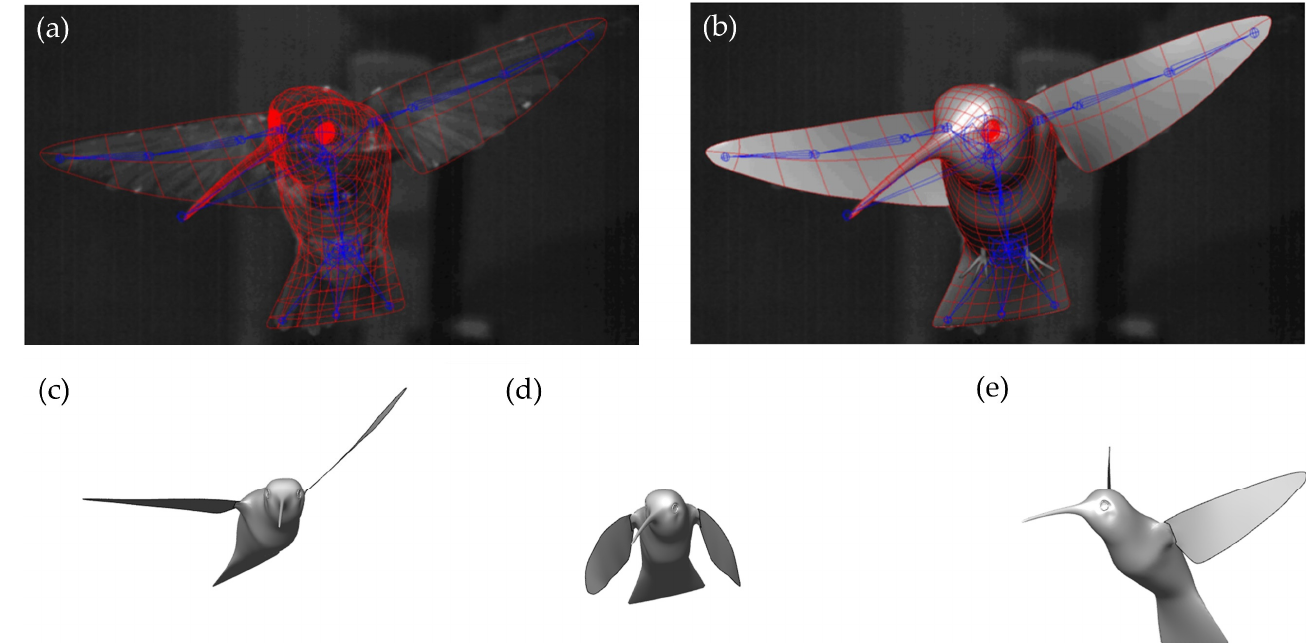
Figure 1. ( a ) Hummingbird skeleton and Catmull–Clark subdivisions superimposed on the real hum- mingbird; ( b ) fully rigged hummingbird model with skin surface; illustration of the hummingbird yaw turn at 3 time instances ( c ) 1 ms; ( d ) 26 ms; ( e ) 54 ms. Figure 2a illustrates the three wing position angles relative to the wing–root coordinate system ( x w y w z w ), in which the x w -axis is parallel with the body longitudinal direction (or root-to-root), the y w -axis is along the lateral direction, and the z w axis complies with the right-hand rule. The mean stroke plane (MSP) serves to indicate the plane formed by the average of the tip positions at the top and bottom of the stroke as well as the wing root. The stroke position angle Ψ w defines the forwards or backwards position relative to the y w axis. The dotted black arrow in the stroke plane represents a projection of the tip to root vector (red vector) onto the stroke plane. To measure the upwards and downwards position with respect to the MSP, deviation angle θ w is used. θ w represents the angle between the base-to-wingtip line and the root–tip vector projection. The angle of incidence (AOI) Φ w is defined as the angle between the least-squares reference plane (LSRP) and the tangent of the wing velocity in the MSP. To compute the LSRP, the displacements of the wing surface nodes relative to a flat wing in the least-squares plane (red outline in Figure 2c)